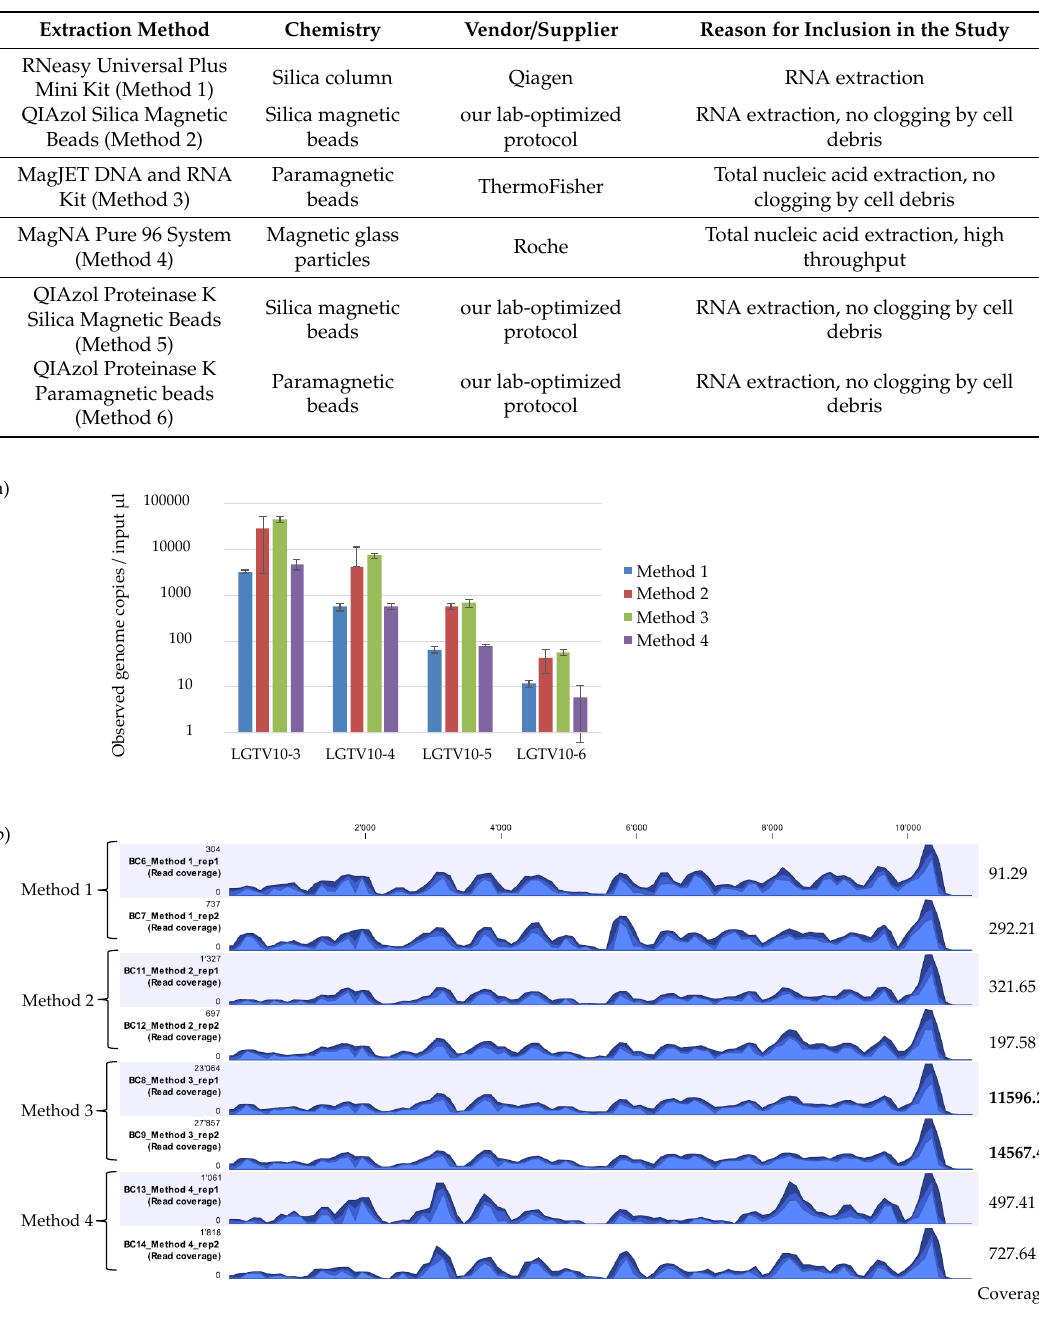
Table 1. Extraction methods used in the study and reasons for their inclusion.